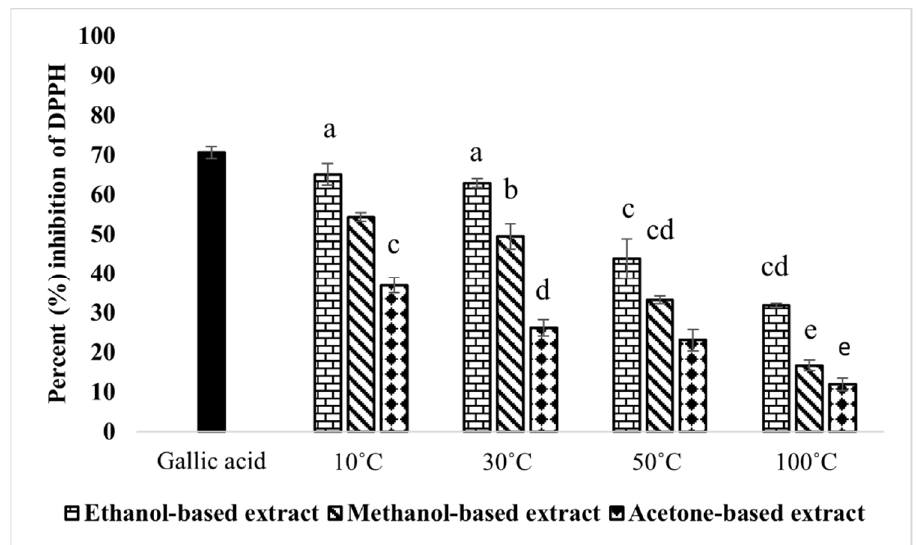
Figure 2. Antioxidant potential of M. oleifera leaves using DPPH assay. The positive control was gallic acid (0.3 mM). Bars displayed the mean based on 3 replicates of each treatment. Significant variations ( p < 0.05) among all extracts are represented by different letters (a–e) above the bars.